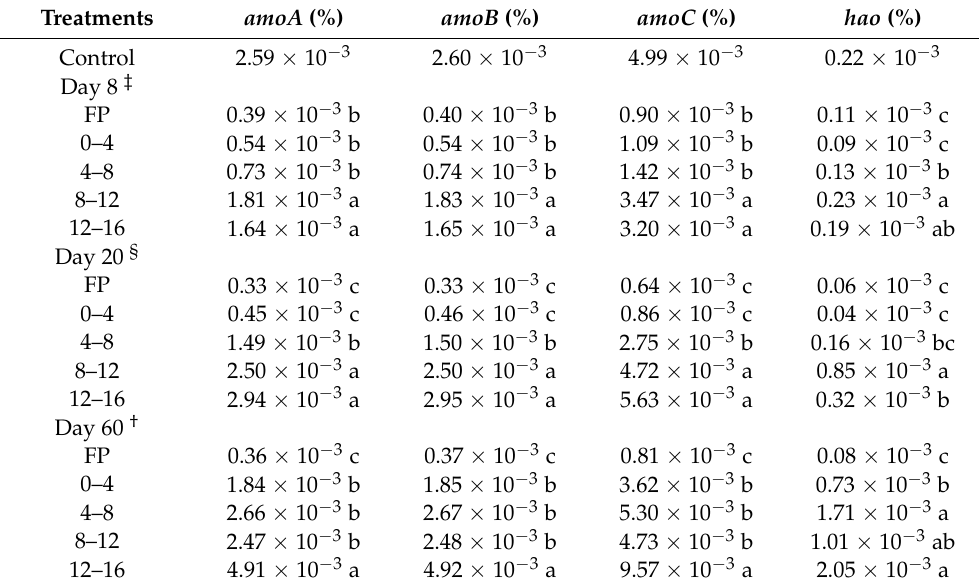
Table 4. The putative abundance of nitrification genes under different treatments and incubation times for Dangtu (DT) soil.